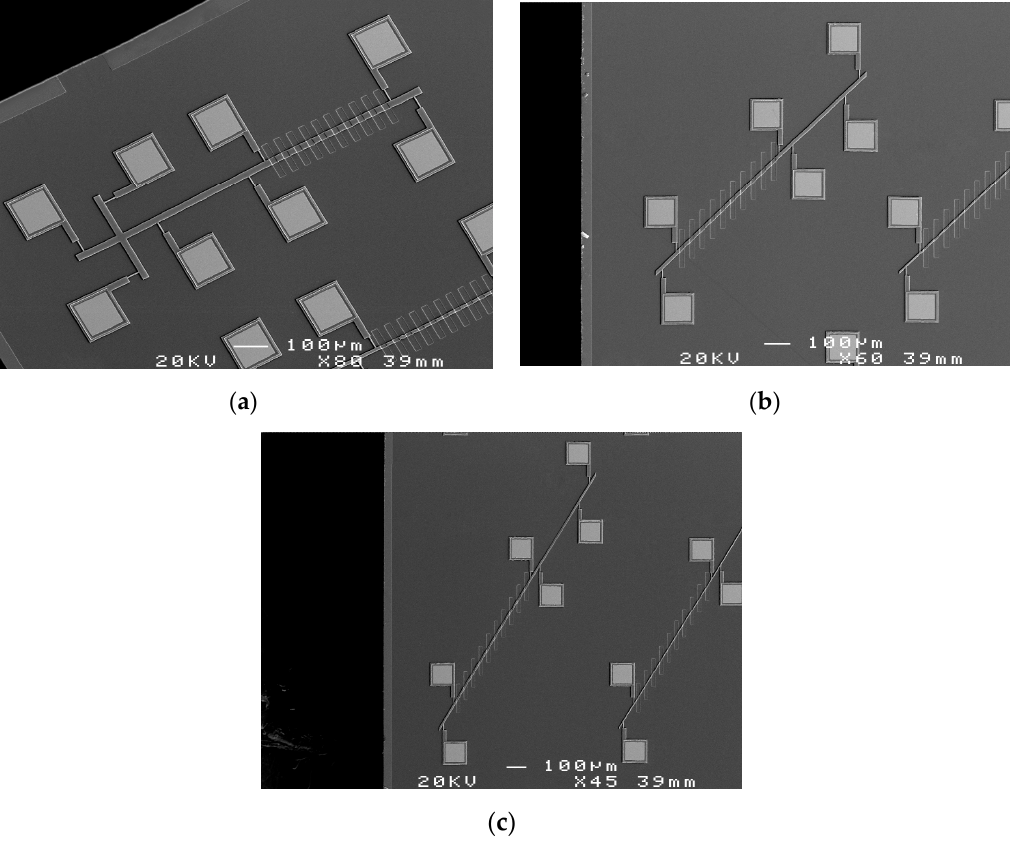
Figure 4. SEM photographs of the test structure: ( a ) Deposited horizontally; ( b ) Deposited at an angle of 45°; ( c ) Deposited at an angle of 60°.